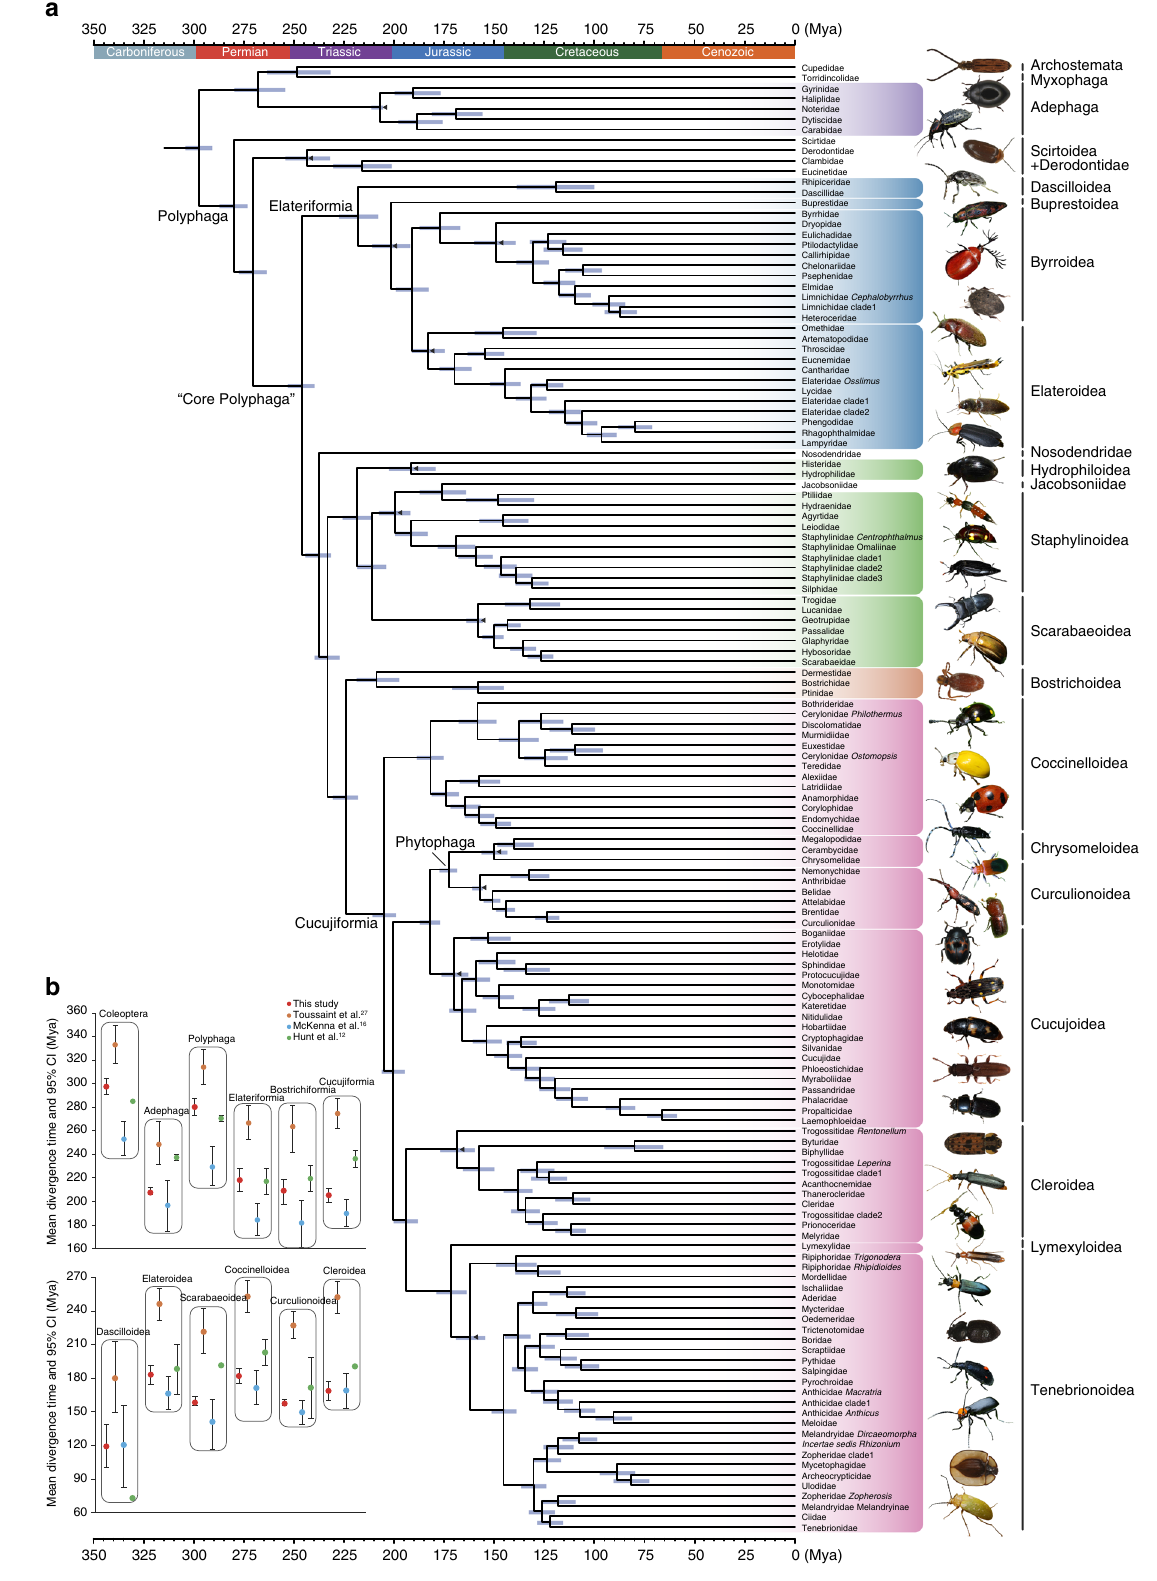
Fig. 3 New timescale for beetle evolution and comparison of divergence times. a Time-calibrated tree of beetles. The time tree was collapsed to family level with outgroups removed (for detailed results, see Supplementary Fig. 8). Divergence times were estimated with MCMCTREE with 20 calibration points, on the basis of the amino acid data set. Fossil constraints within Coleoptera are shown with black triangles. Horizontal bars represent 95% credibility intervals. b Comparison of divergence time estimates for twelve major nodes sharing across four beetle time trees. The circle represents the mean age, and the whiskers mark the 95% credibility internals (Photo credits: Hong Pang, Yun Li, and Zhenhua